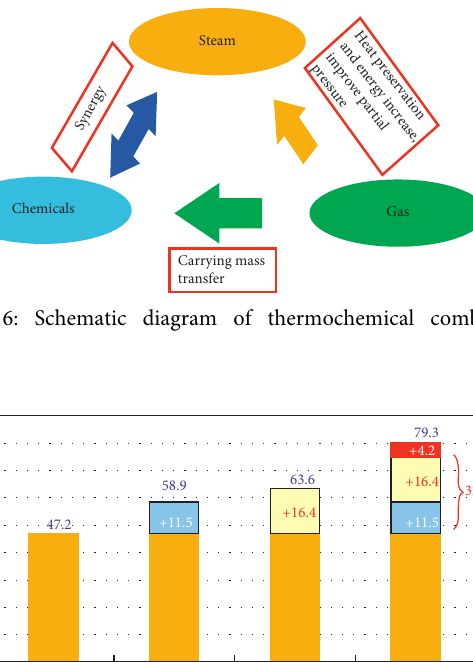
Figure 7: Comparison of the oil displacement efficiencies of the different displacement